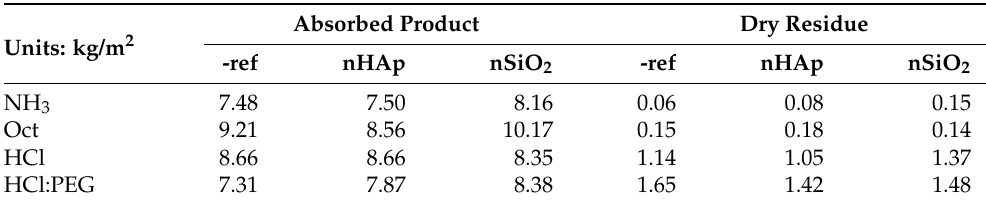
Table 4. Absorbed product and dry residue after the treatment procedure on the stone specimens (in kg/m 2